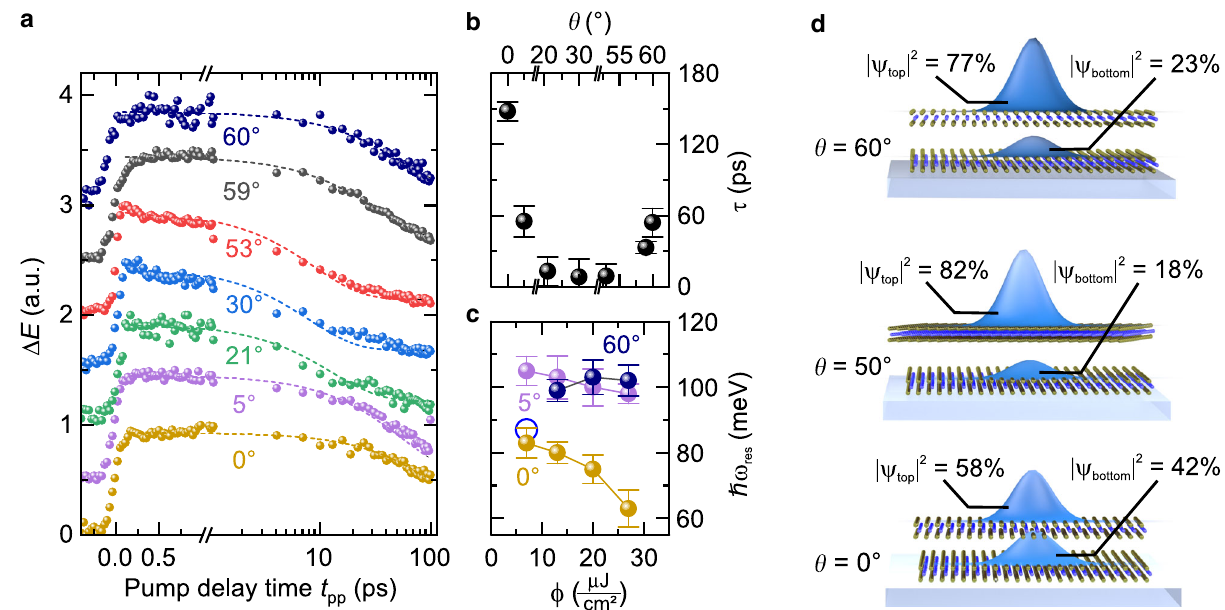
Fig. 4 Ultrafast dynamics and density-dependent energy renormalization of hybridized excitons. a Pump-induced change of the mid-infrared electric fi eld Δ E as a function of the pump-probe delay time t fi xed electro-optic sampling time t = 0 fs for different twist angles θ (spheres). pp recorded at eos Curves are vertically offset for clarity. The dashed lines represent fi ts to the data with an exponential decay. b Exciton decay time τ as a function of the twist angle θ , determined by the decay constant of the fi t in a . The error bars indicate one standard deviation. c 1 s – 2 p resonance energy ħ ω res for different pump fl uences Φ at a pump-probe delay time t = 5.1 ps recorded for twist angles θ = 0°, 5°, and 60°, respectively (spheres). The resonance energies were pp extracted from the dielectric response by fi ts to a phenomenological model (see Supplementary Fig. 5). The blue circle marks the resonance energy derived from the microscopic theory shown in Fig. 2c. The sample was kept at a temperature of 5 K. The error bars represent the 95% con fi dence interval of the fi tting procedure. d Calculated probability density of the electron within the two layers for a hybrid exciton for twist angles θ = 60°, 50°, and 0°, where the hole is chosen to remain at a fi xed position in the top